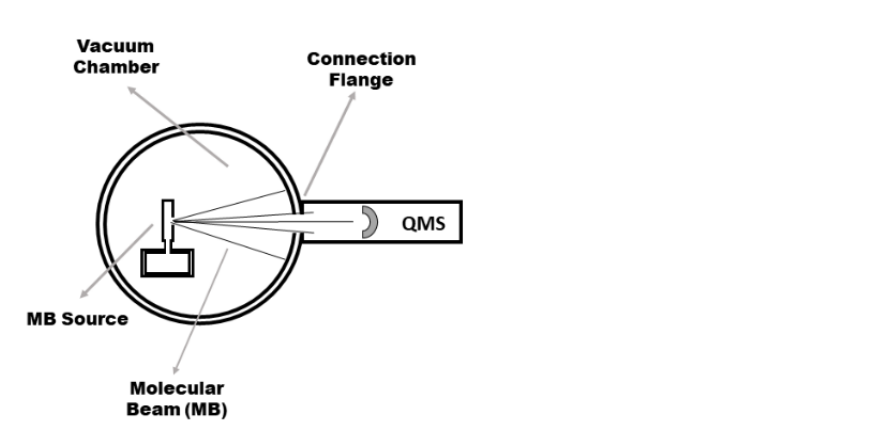
Figure 1. Top view of the molecular-beam thermal desorption spectrometry (MB-TDS) configura- tion.